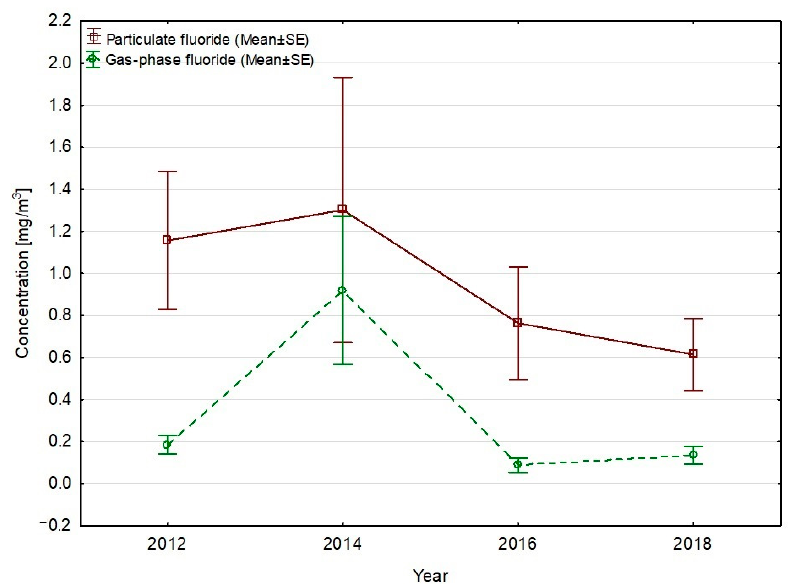
Figure 1. Comparison of the determined concentrations of fluoride in the occupational environment during the research period.